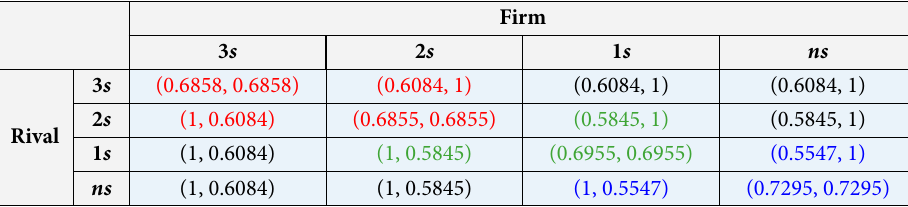
Table 3. Technological transition: two observations, risk-neutral DM, and signals on X 2